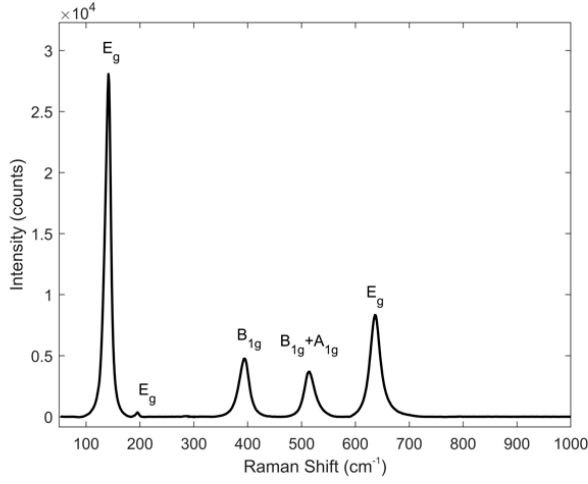
Figure 2. Stokes Raman spectrum of titanium dioxide anatase excited at 488.0 nm, with input power of 1.72 mW, with the indication of the Raman mode symmetry.